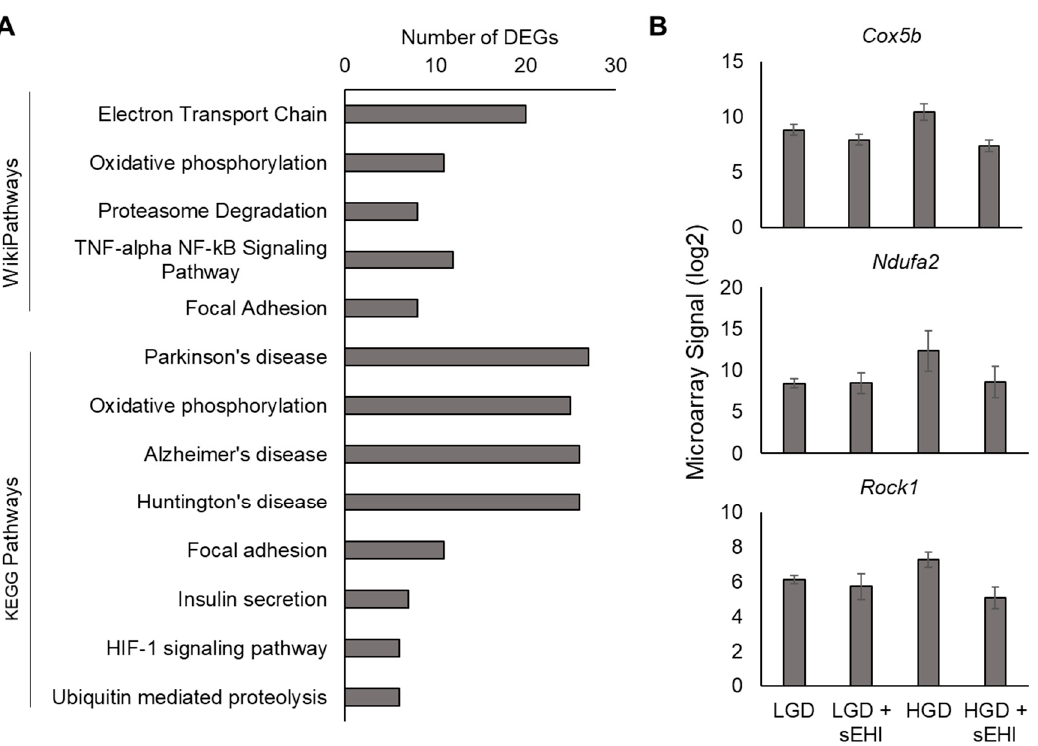
Figure 10. Analysis of DEGs with a significant interaction of diet and inhibitor. ( A ) Relevant enriched WikiPathways and KEGG Pathways for DEGs with an interaction between diet and inhibitor effects. ( B ) Signal plots of selected DEGs with an interaction between diet and inhibitor effects. Data shown are from three biological replicates (mean +/ − standard deviation). The DEGs displayed are cytochrome c oxidase subunit Vb (Cox5b), NADH dehydrogenase (ubiquinone) 1 alpha subcomplex 2 (Ndufa2), and Rho-associated coiled-coil containing protein kinase 1 (Rock1).